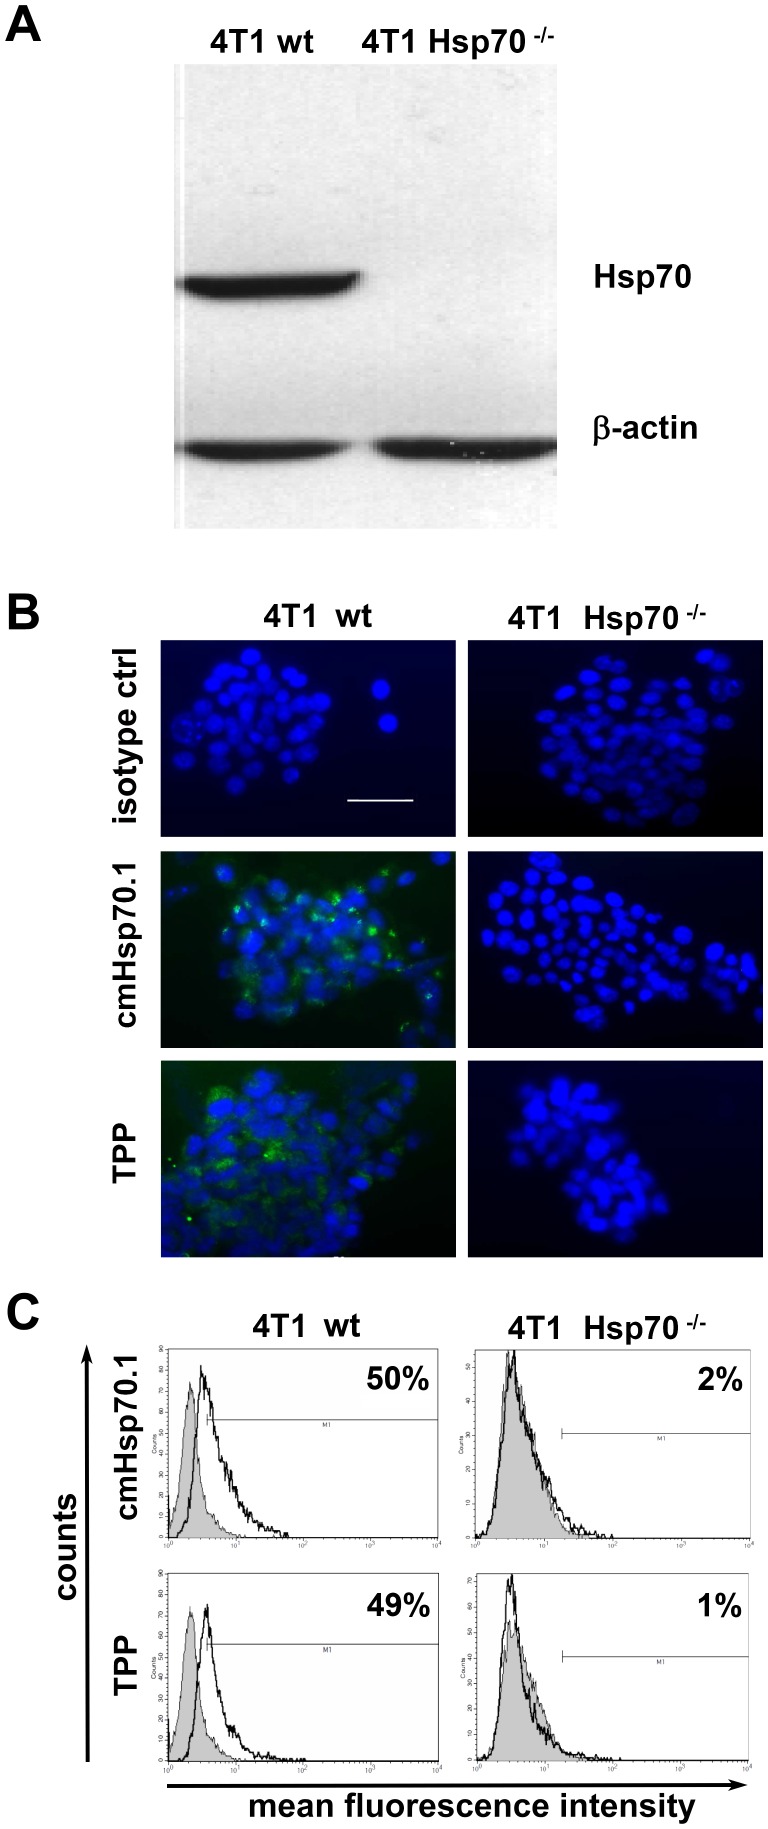
TPP specifically binds to Hsp70 in vitro.
A. Western Blot analysis of whole cell lysates of 4T1 Hsp70 wild type (4T1 wt) and 4T1 knockout (4T1 Hsp70−/−) cell lines showed a positive Hsp70 staining in 4T1 wt but not in 4T1 Hsp70−/− cells using the cmHsp70.1 antibody; ß-actin was used as a loading control. B. Immunofluorescence staining and C. flow cytometric analysis of in vitro grown viable 4T1 wt and Hsp70−/− cells proved the Hsp70 specificity of CF-labeled TPP. Binding of TPP to 4T1 wt cells was comparable to that of cmHsp70.1 antibody (left panel, green staining). Neither TPP nor cmHsp70.1 antibody did bind to 4T1 Hsp70−/− cells (right panel). Cells were counter-stained with DAPI (blue staining). C. Representative flow cytometric histograms indicate a positive Hsp70 staining of 4T1 wt cells by cmHsp70.1 antibody and TPP. In contrast, 4T1 Hsp70−/− cells were neither stained with cmHsp70.1 antibody nor with TPP; grey, isotype controls, open histograms, Hsp70 specific reagents. The numbers in the histograms show the proportion of Hsp70 membrane-positively stained cells.